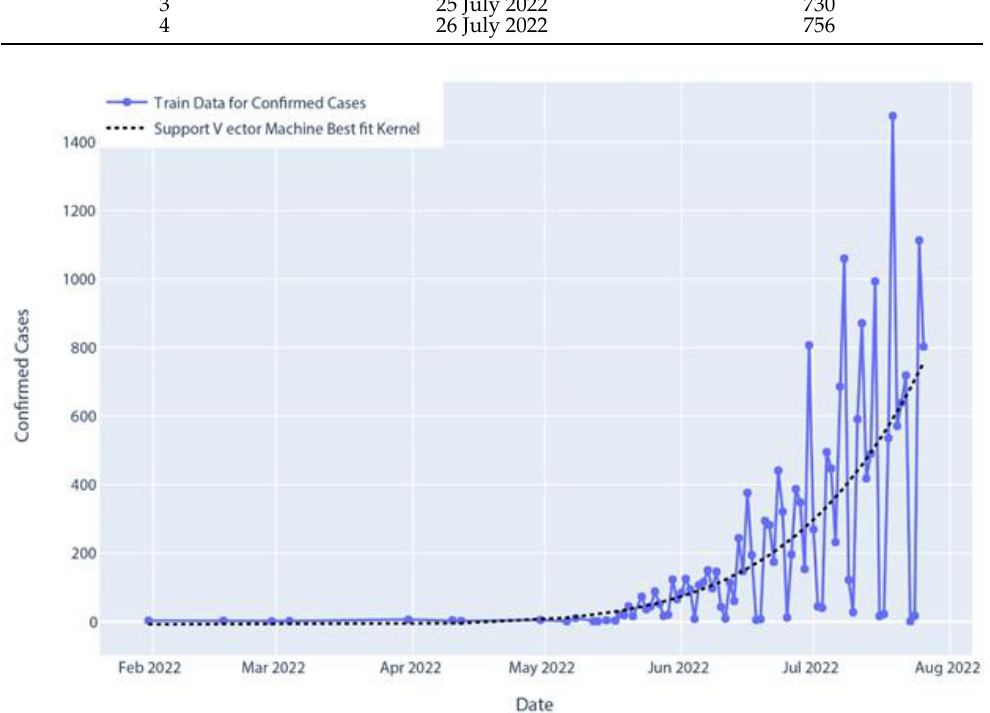
Figure 16. Confirmed cases of SVR (support vector regression) prediction.